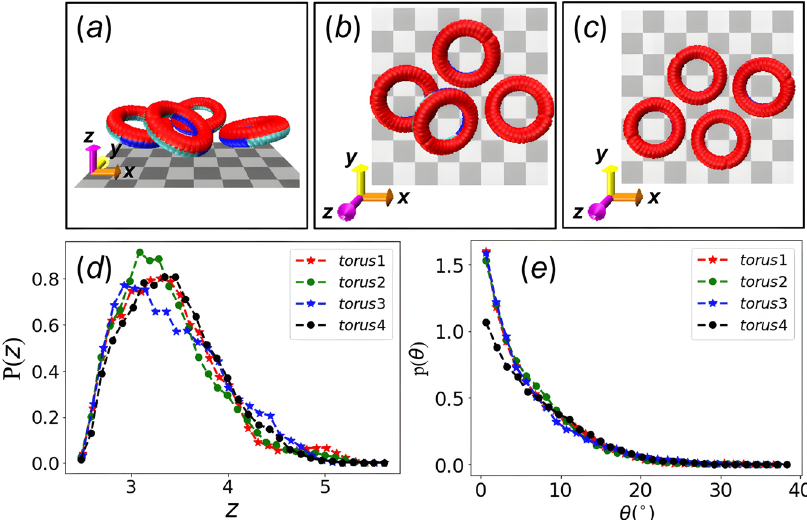
Fig. 8 Bound state for four tori near the wall for g = 0.09,7D2 ϵ cd = 0.2. a – c Instantaneous con fi gurations of metastable bound states of four forward- moving tori near the wall; a and b top and side views at the same time instant, c top view from another realization of the dynamics at a given time instant. d – e P ( z ) and p ( θ ) probability distributions constructed from 25 realizations of the dynamics, the symbols show the mean values. The red colour indicates the catalytic surface. The blue/green facets correspond to the non-catalytic surface. The torus moves with the blue facet